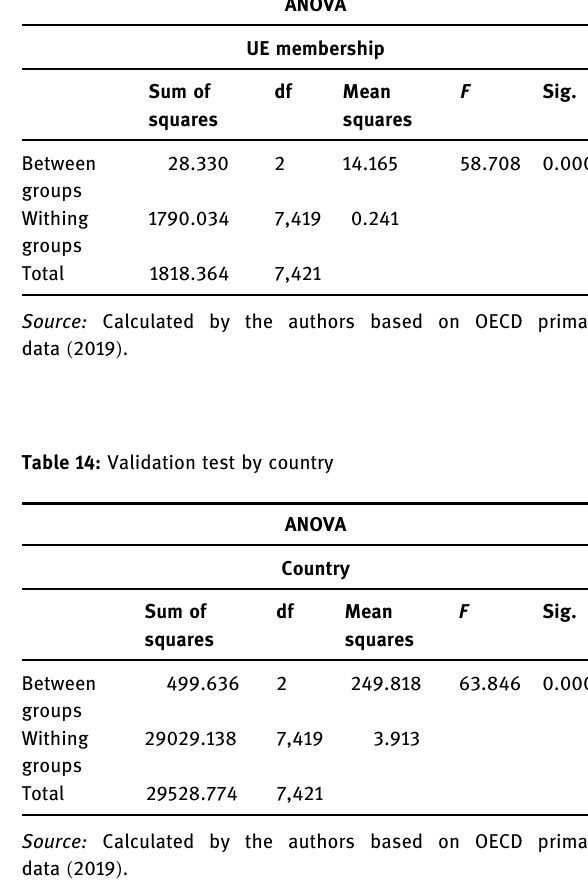
Table 13: Validation test by EU membership